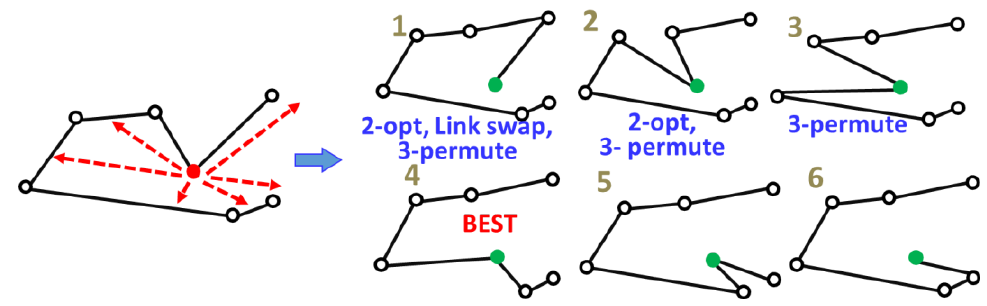
Figure 8. Six neighboring solutions created by relocate, of which three are unique.